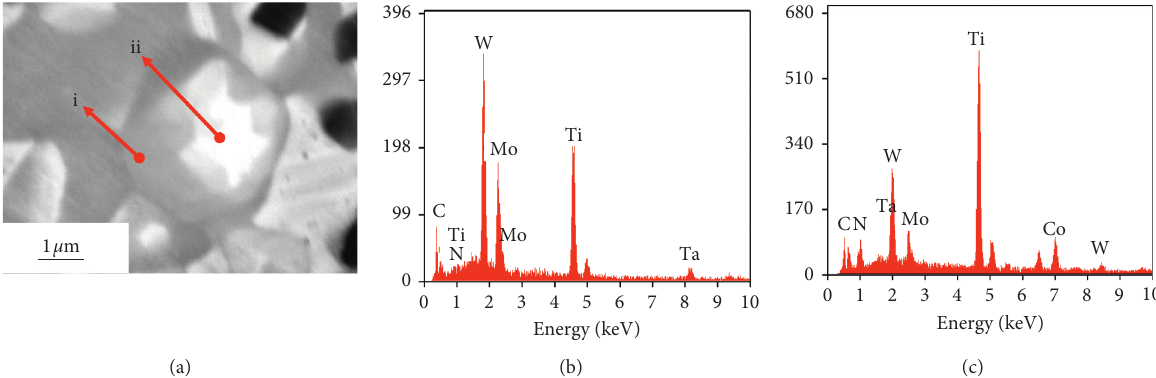
Figure 12: Energy spectra of a white core and gray rim. (a) BSE morphology of core-rim, (b) energy spectrum of (i) white core, and (c) energy spectrum of (ii) gray rim.